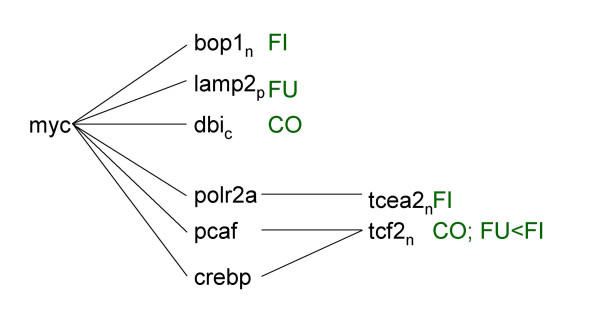
Pathway analysis. Figures 3-7 represent signaling pathways for 58 focus genes selected from Table 3 by Ingenuity Systems software (Redwood City, CA. The following signaling cascades are shown: JUN, TNF, and CDKN2A signaling cascade affecting: DNA replication; recombination and repair; immune response; and cell cycle (Fig. 3); TGFB1 signaling cascade affecting: cell morphology; cancer; and tumor morphology (Fig. 4); CTNB1 signaling cascade affecting: cell signaling; gene expression; and cell cycle (Fig. 5); INS1/hRAS signaling cascade affecting: carbohydrate metabolism; endocrine disorders; and metabolic disease (Fig. 6); and MYC signaling cascade affecting: viral function; gene expression; and cell Cycle (Fig. 7). Differentiating groups (per Table 3) are overlaid onto the signaling diagrams, and abbreviated: FU, fungal; FI, fish oil; CO, combination diet. When CO was the differentiating group, absolute differences between FU and FI are indicated. Intracellular location of focus genes (subscripts) are annotated: C, cytoplasm; E, extracellular; N, nucleus; P, plasma membrane; U, unknown. Major canonical functional/signaling categories associated with genes in the figures identified by the software, are shown in yellow boxes.